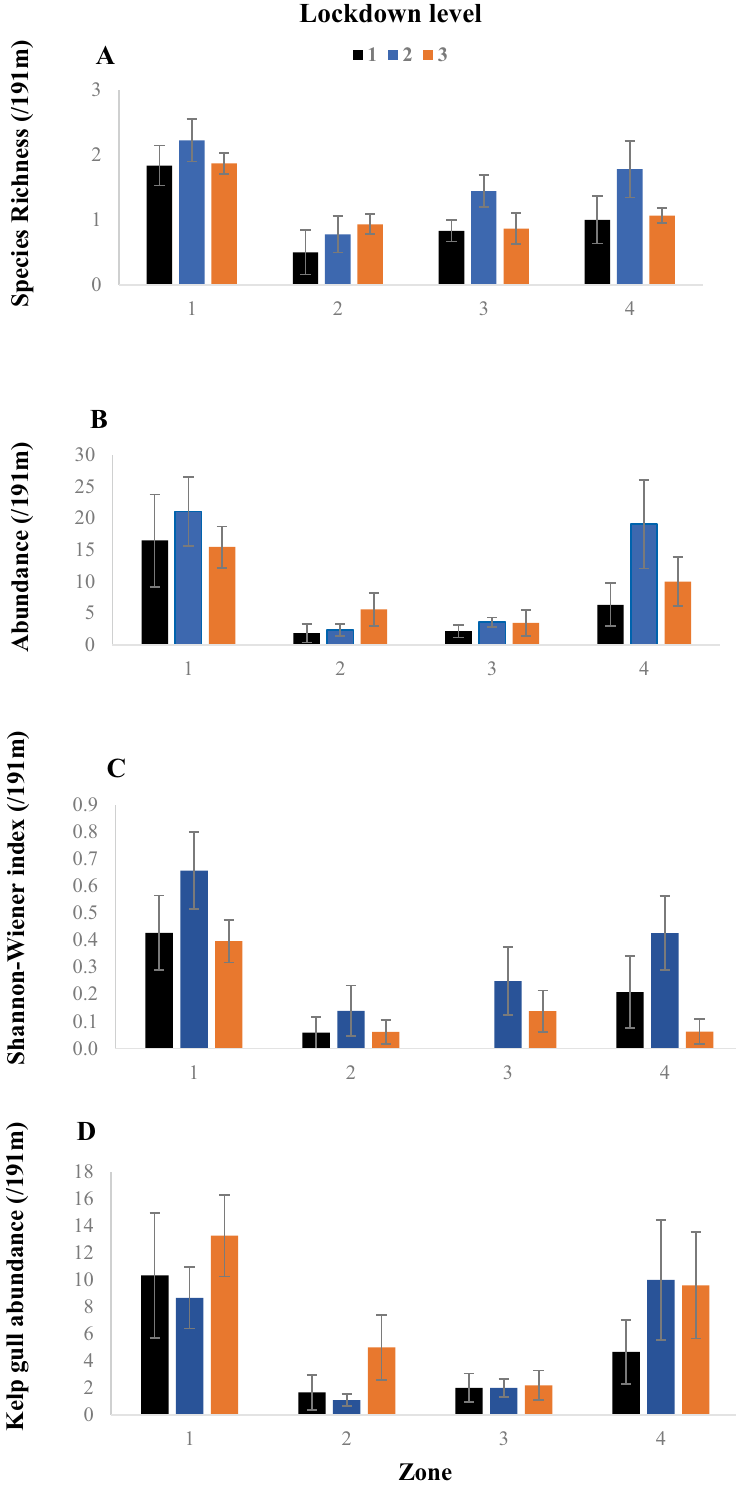
Figure 5. Variation of mean shorebird (± SE) ( A ) species richness, ( B ) abundance, ( C ) Shannon-Weiner diversity and ( D ) mean (± SE) abundance of L. dominicanus (± SE) for four zones on Muizenberg Beach during lockdown levels 3 to